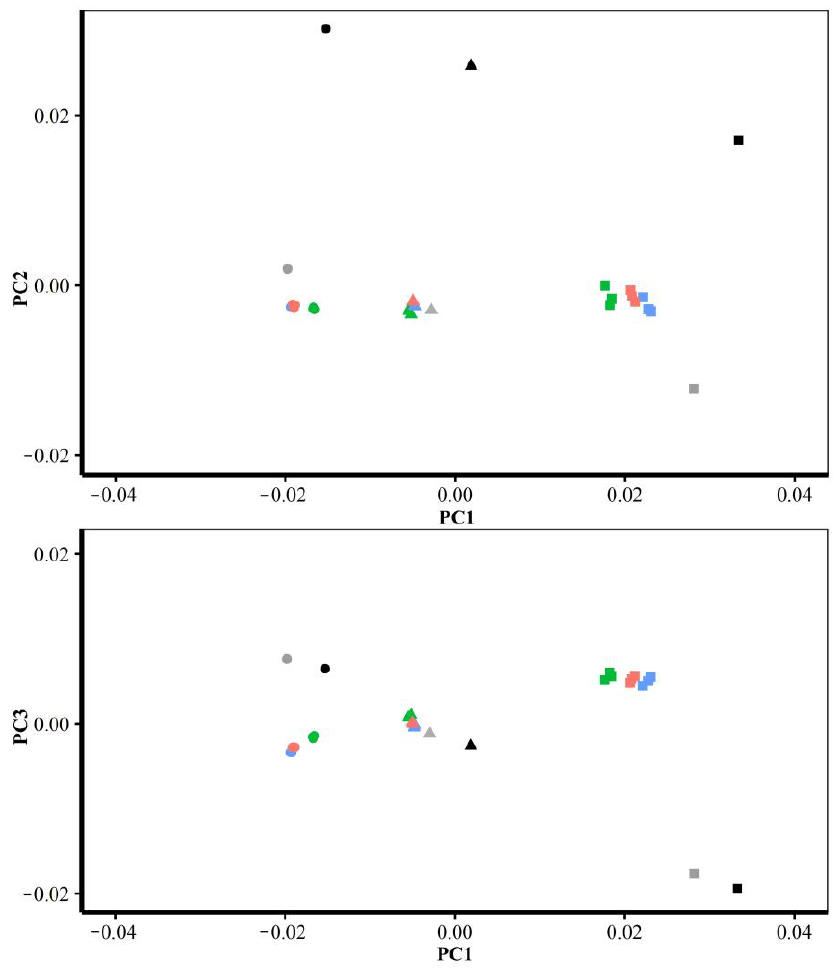
Figure 27. Top: PC1 (72.1% of total variance) vs. PC2 (17.5%); bottom: PC1 vs. PC3 (5.36%) from PCA of the mean and allometrically scaled head surfaces derived using varying semilandmark densities from each semilandmarking approach (from Figure 17). Red = sliding TPS, blue = TPS&NICP, green = LS&ICP. Also included in this PCA are surfaces warped to the mean and scaled landmark configurations; the head surface with minimum Procrustes distance from the mean (black); and the template surface (grey). Triangles = means, squares = allometric predictions of surfaces at the sample minimum centroid size, circles = allometric predictions of surfaces at the sample maximum centroid size.